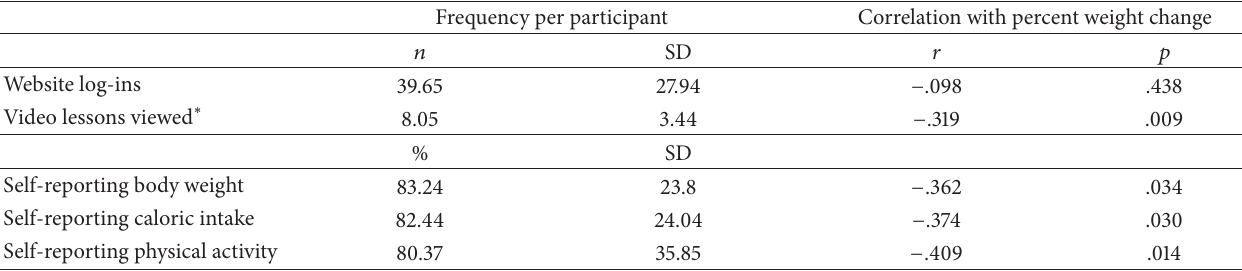
Table 2: Website engagement and adherence to self-monitoring during the intervention, and the association between these factors and weight loss at Month